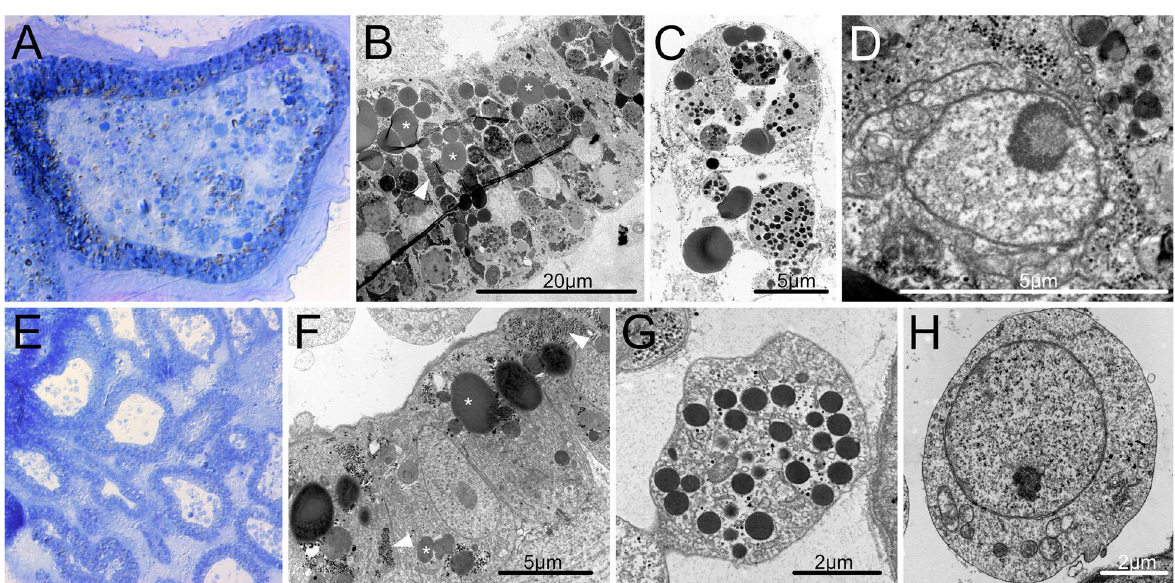
Figure 7. Cell types in dormant stages of Clavelina lepadiformis and Polyandrocarpa zorritensis include nutrient storage cells and putative stem cells. ( A – D ) C. lepadiformis : ( A ) Methylene blue staining of winter bud histological section shows a thick layer of epithelial cells surrounded by tunic and enclosing abundant mesenchymal cells. ( B ) TEM image of epithelial cells, many with lipid and glycogen inclusions, labeled with asterisk and white arrowheads, respectively. ( C ) TEM image of a phagocyte with contents inside mesenchymal space. ( D ) Putative hemoblast cell inside mesenchymal space, as indicated by large nucleolus and small cell size (about 5 microns). ( E – H ) P. zorritensis . ( E ) Methylene blue staining of spherule histological section shows numerous ampullary spaces lined with epithelium and filled with sparse hemocytes. ( F ) TEM close-up image of epithelial cells of ampulla, showing inclusions of lipids (asterisks) and glycogen (white arrowheads). ( G ) Example of a mesenchymal cell with inclusions. ( H ) TEM image of putative hemoblast cell within the mesenchymal space, as indicated by large nucleolus, small cell size, and round cell phagosomes of the macrophage-like cells are filled with material containing electron-dense inclusions (Fig. 7C). These cells are tightly packed and surrounded by non-cellular debris (Fig. 7A–D). In order to test if developmental events in spherule germination resemble budding in P. zorritensis bud- ding nests, spherules maintained at 10 °C were transferred to a higher temperature (24 °C) and fixed after 48 h. In developing spherules, the vascular epidermis invaginated in a similar way as in developing budding nests (Fig. 8B). These results suggest that the epidermal morphogenetic movements that occurred in germinating